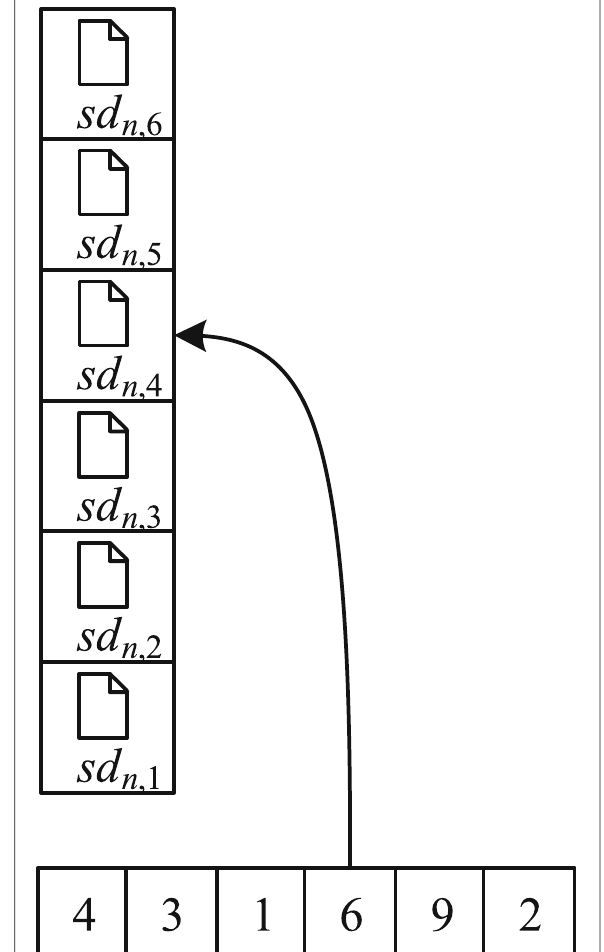
Fig. 2 An example of encoding